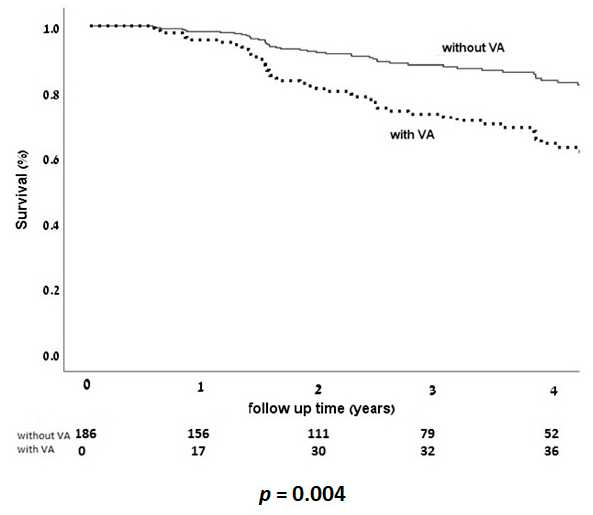
Figure 4. Survival KM curves according to presence or absence of VA, as a time dependent covariate. Occurrence of VA had a significant impact, increasing overall mortality. p < 0.05 is considered significant.